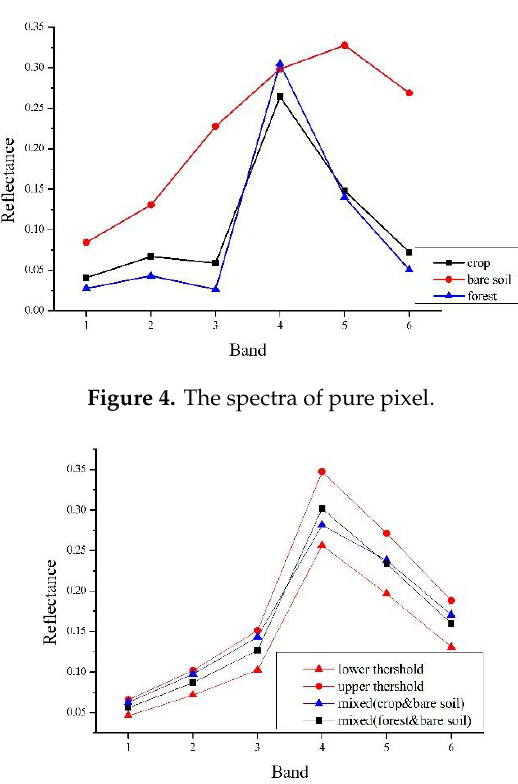
Figure 5. The mixed spectra and spectral threshold of central pixel.